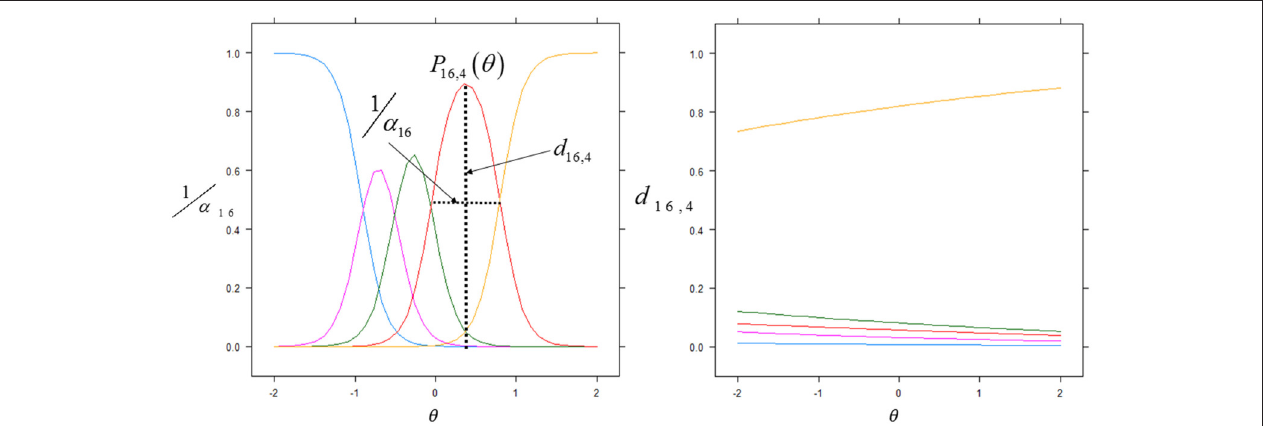
FIGURE 2 | Item discrimination profiles for two items. The curves depict the probabilities of scoring a response at level l for item j : P j , 1 ( θ ) . The profiles on the left are those of item 16 (Spontaneous Non Verbal Communication with other Children) for which each level of the Likert scale responses exhibits good discrimination between scores. We highlight the probability density curve for the 4th level of this item and indicate both the discrimination and the intercept for this curve. The profiles on the right are those of item 3 (Sleepiness) which elicited highly unreliable scoring from the evaluators.